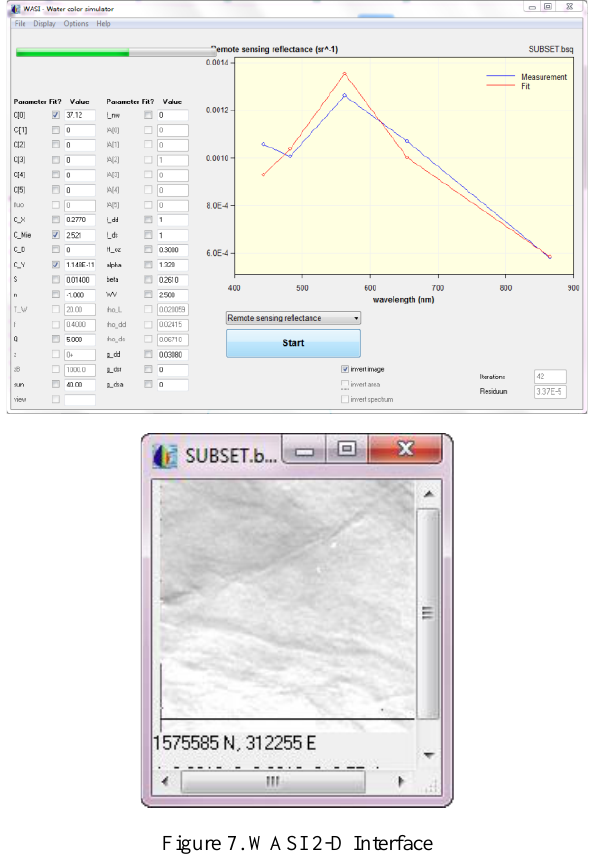
Figure 7. WASI 2-D Interface